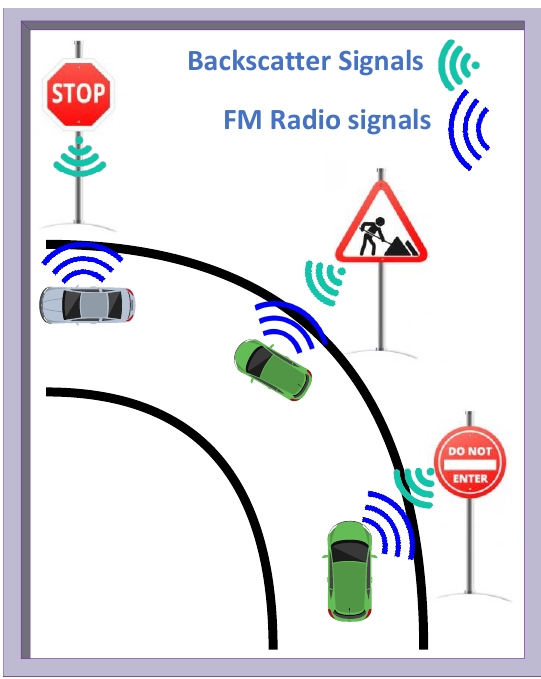
Figure 48. Vehicle safety using